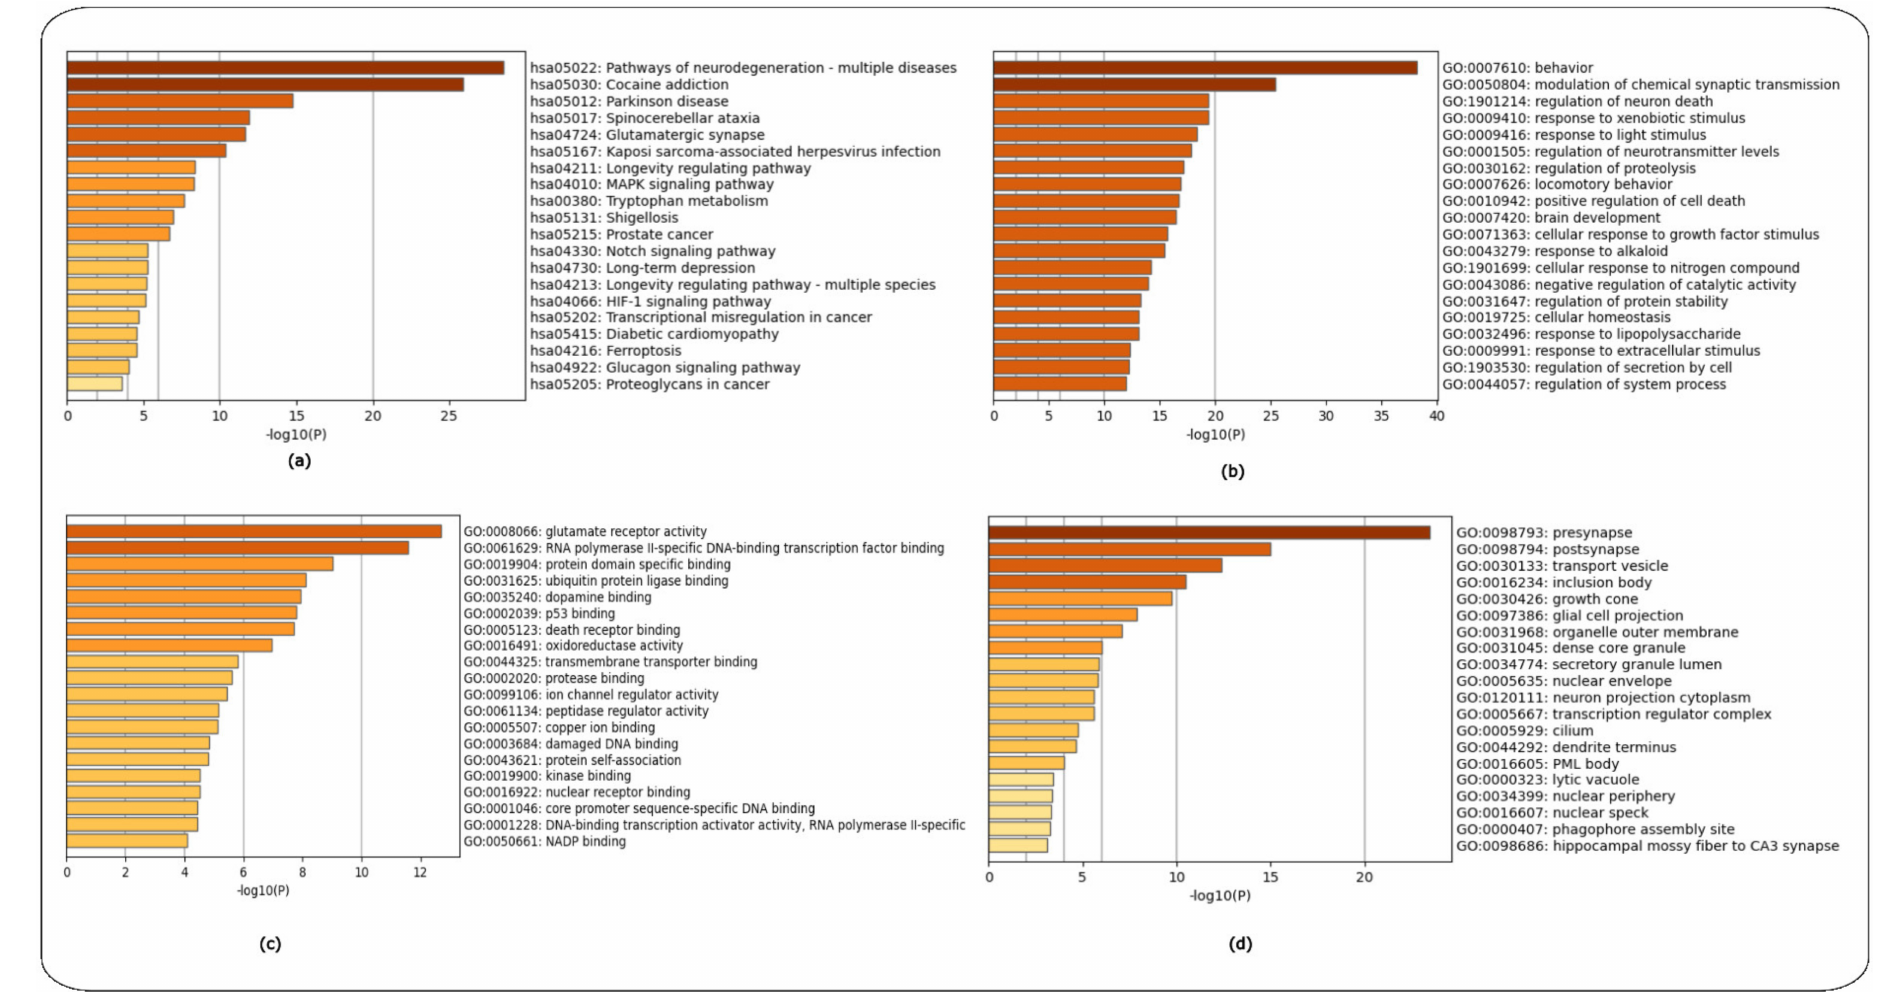
Figure 9. Enrichment analysis of gene targets shared between the public databases of CTD, Malacards and Disease Database using the KEGG and GO libraries in Metascape. ( a ) KEGG pathways, ( b ) GO-Biological Process, ( c ) GO-Molecular Function and ( d ) GO-Cellular